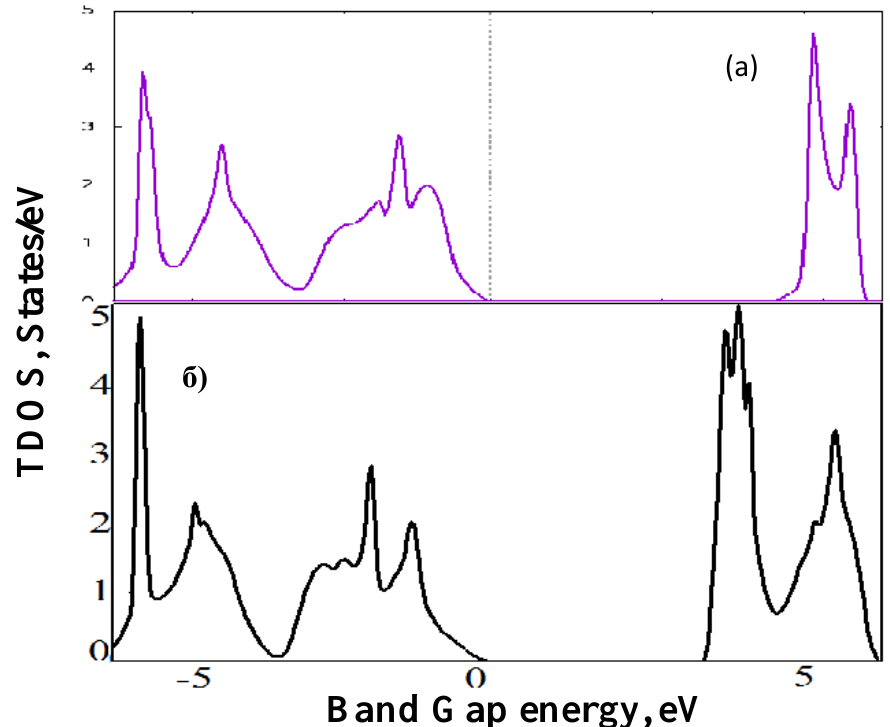
Figure 2. Densities of electronic states: a) for ZrO 2 [34], b) for pure TiO 2 . Fermi level approaches point 0 (b) and dotted lines in